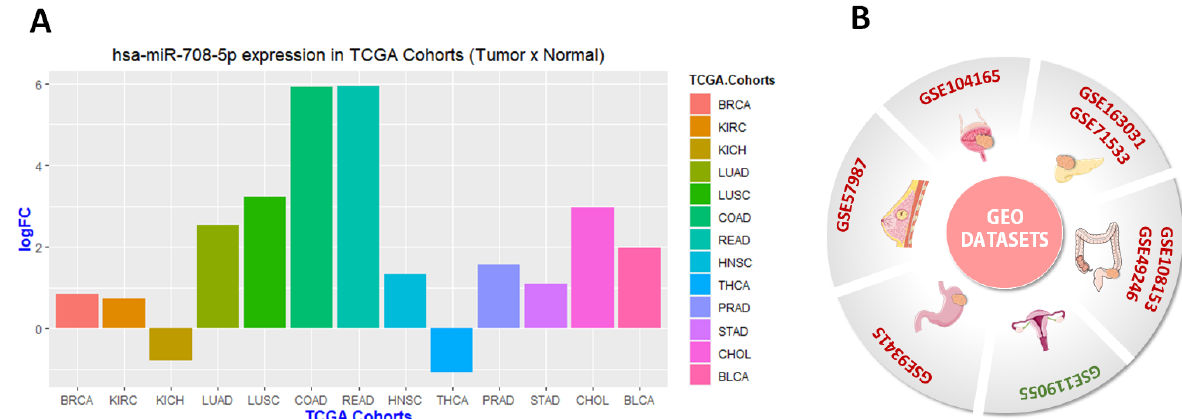
Figure 4. In silico analysis of miR-708 expression in human cancers. ( A ) Graphical representation of TCGA cohorts with miR-708 differential expression. The Y axis represents logFC values and the X axis TCGA cohorts. TCGA cohorts abbreviations: BLCA — bladder urothelial carcinoma; BRCA —